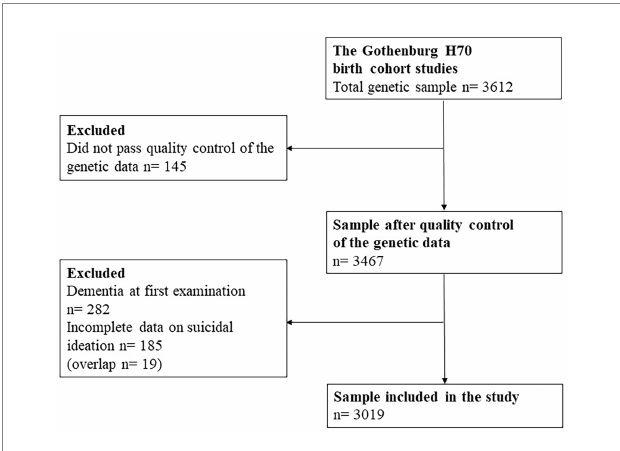
FIGURE 1 Flow diagram of the study